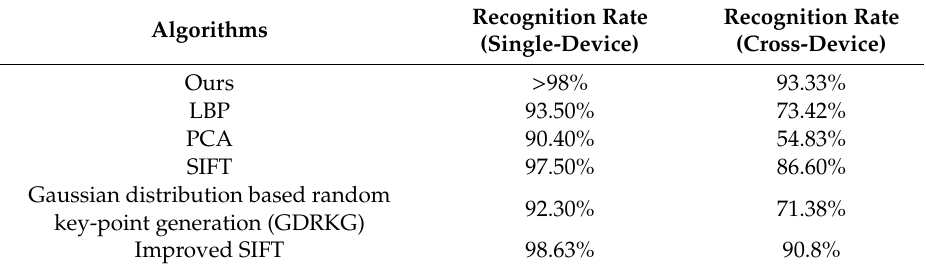
Table 2. Comparison of recognition rates about different algorithms under cross ‐ device.